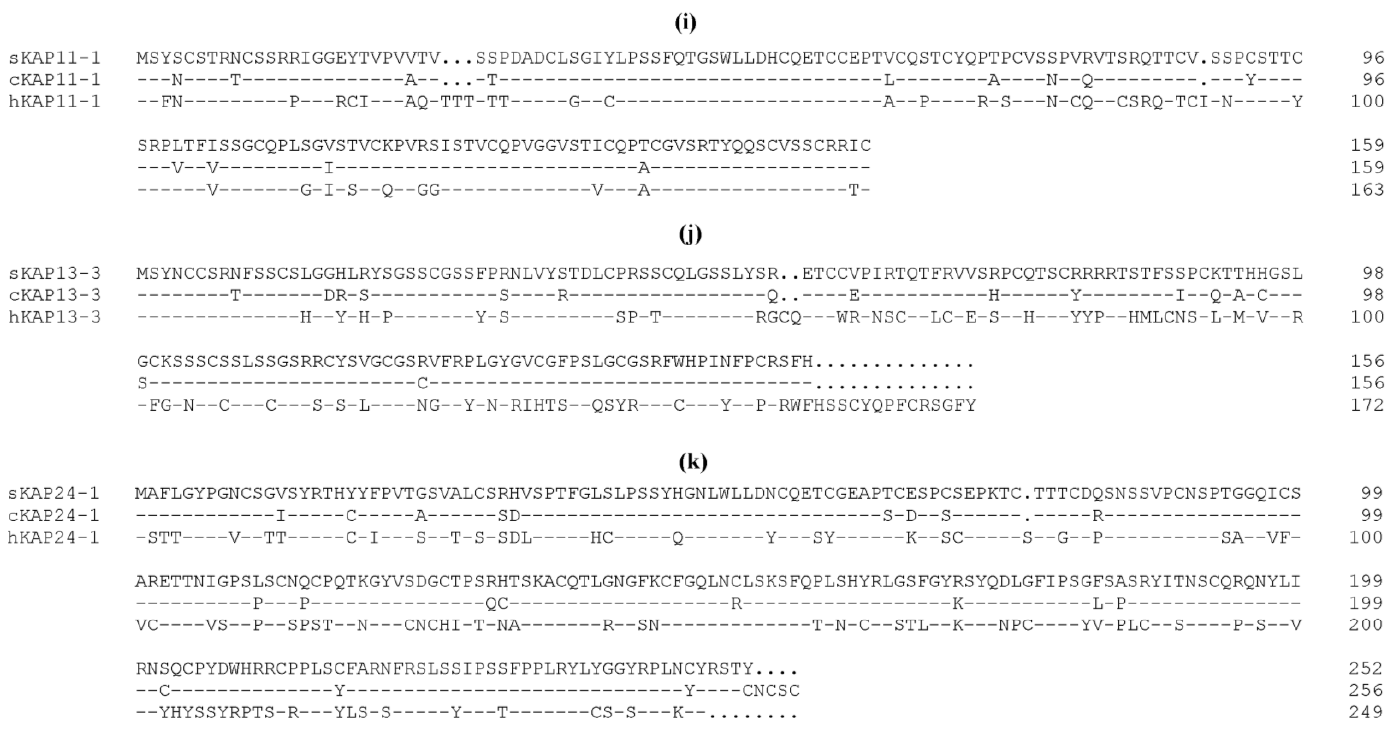
Figure 1. Amino acid sequence alignments of representative sequences from the ovine KAP families and orthologous sequences from other species. ( a ) KAP1-n; ( b ) KAP2-n; ( c ) KAP3-n; ( d ) KAP4-n; ( e ) KAP5-n; ( f ) KAP6-n; ( g ) KAP7-1; ( h ) KAP8-n; ( i ) KAP11-1; ( j ) KAP13-3; and ( k ) KAP24-1. The dashes represent amino acids identical to the top sequence and the dots act as spacers to improve alignments. The QTSCCQPXXX decapeptide repeat sequence found in KAP1-n and the CCVPX pentameric repeat sequence found in KAP2-n are shown in boxes. The central region consisting of contcatenates of nonocysteine- and dicysteine-containing pentameric repeats found in KAP4-n is shaded. In KAP5-n, the glycine-rich decapeptide repeat sequence is boxed, whereas the cycteine/serine-rich decapeptide repeat sequence is both boxed and shaded. All the amino acid sequences are predicated from DNA sequences, except for those indicated by * which were derived directly from protein sequencing. # indicates a partial sequence. The sheep, goat, cattle and human sequences are indicated with a prefix of “s”, “g”, “c” and “h”, respectively. Accession numbers or references for the ovine sequences are shown in Table 1, and those from other species are: AB096962 (hKAP7-1); AY510121 (gKAP7-1); AP001709 (hKAP8-1); AY510123 (gKAP8-2); NM_001080740 (cKAP11-1); NW_001838706 (hKAP11-1); ENSBTAG00000040032 (cKAP13-3); NM_181622.1 (hKAP13-3); XM_002684598.1 (cKAP24-1) and NM_001085455 (hKAP24-1).